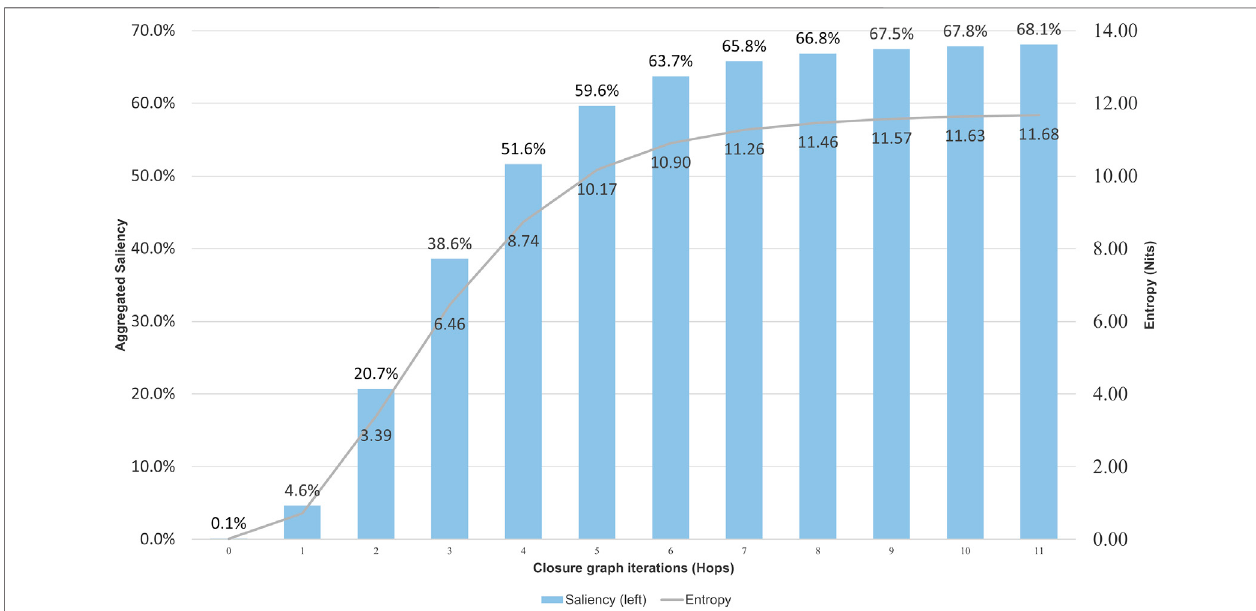
FIGURE2| Information density represented asentropy in nits, and saliency for each hopin theCOVID-19 Research Dataset (CORD-19) closure graph expansion. As a reference, the entropy of the entire Microsoft Academic Graph dataset is 16 nits.